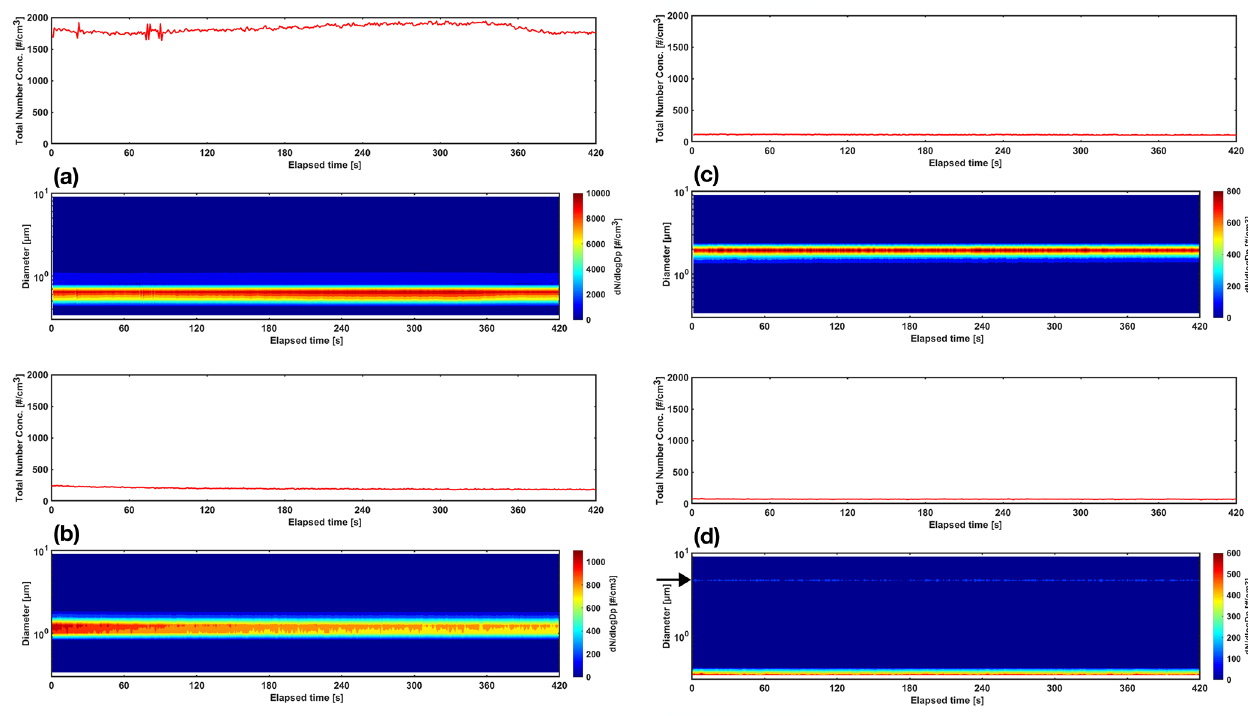
Figure 3. Total particle number concentrations and particle number size distributions as function of time for different sized polystyrene latex spheres generated with PROTeGE and detected by the OPS: (a) 0.75µm, (b) 1.5µm, (c) 2.0µm and (d) 5.0µm where the black arrow denotes the PSL particle size and the small particles represent atomized matrix material (see text for details).